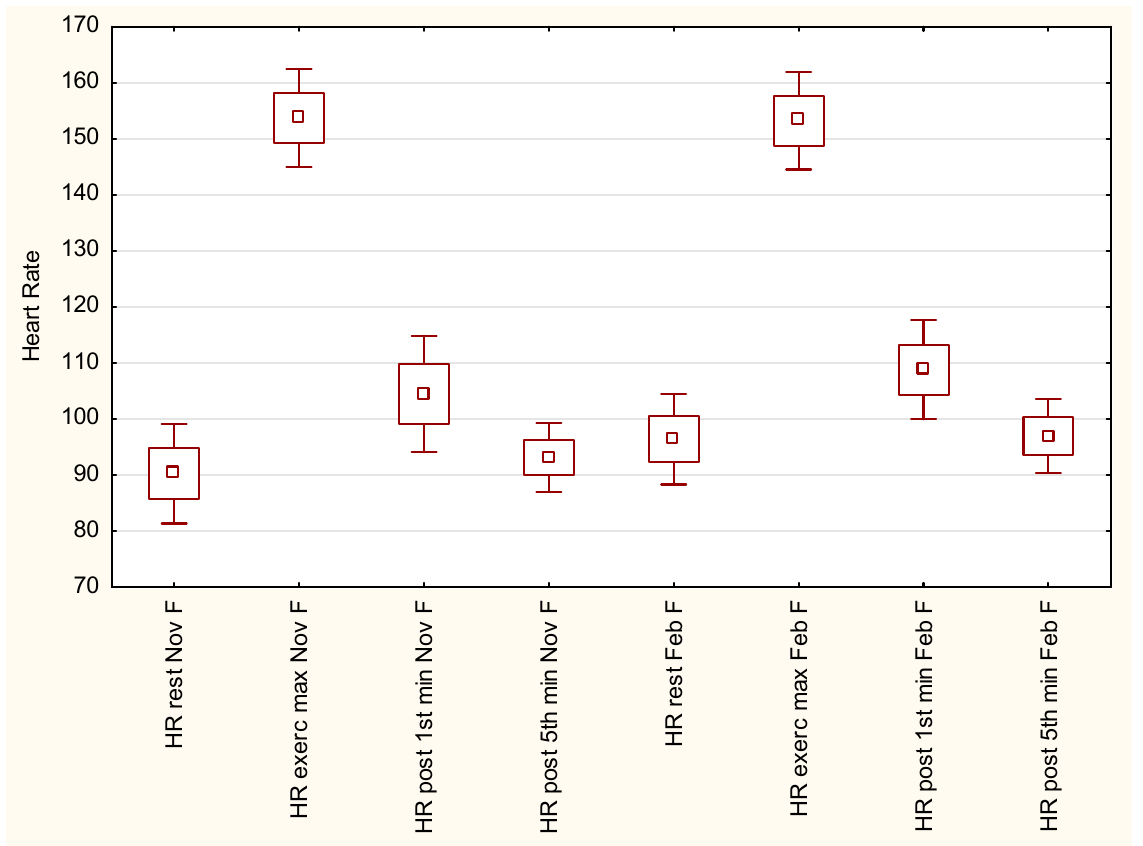
Figure 1. Heart-rate variation in female students in autumn and winter sessions of Physical Work Capacity 170 test.